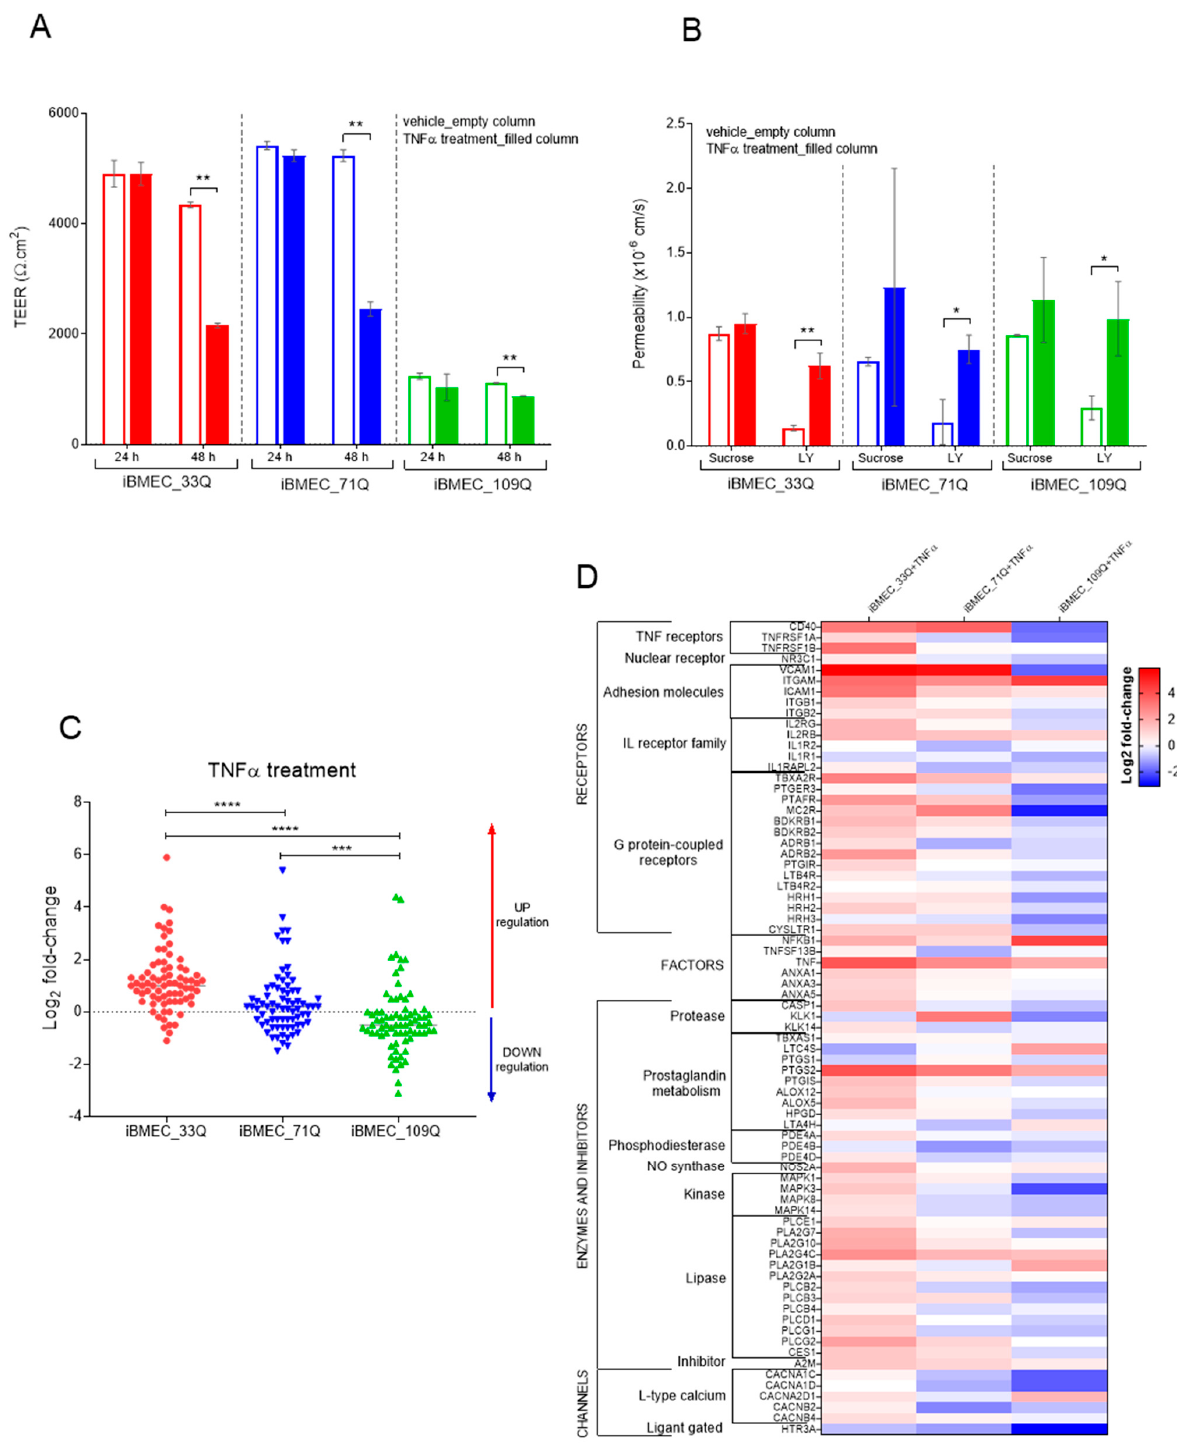
Figure 9. Responsiveness of the BBB Models to TNF α . ( A ) TEER measures after 24 h and 48 h of TNF α treatment (filled columns) and control cells (empty columns); n = 3. ( B ) Paracellular markers permeability after 48 h of TNF α treatment (filled columns) and control cells (empty columns); n = 3. Statistical analysis (for TEER and Permeability) by Student’s t -test: * p < 0.05 and ** p < 0.01. ( C ) Change in the expression of selected genes in iBMECs after TNF α treatment; n = 75. Statistical analysis: two-way ANOVA followed by Bonferroni post hoc test, where *** p < 0.001 and **** p < 0.0001 and ( D ) heat map of the expression by family. Values are expressed as Log2 fold change expression after treatment reported to the untreated cells for each gene normalized to GAPDH.